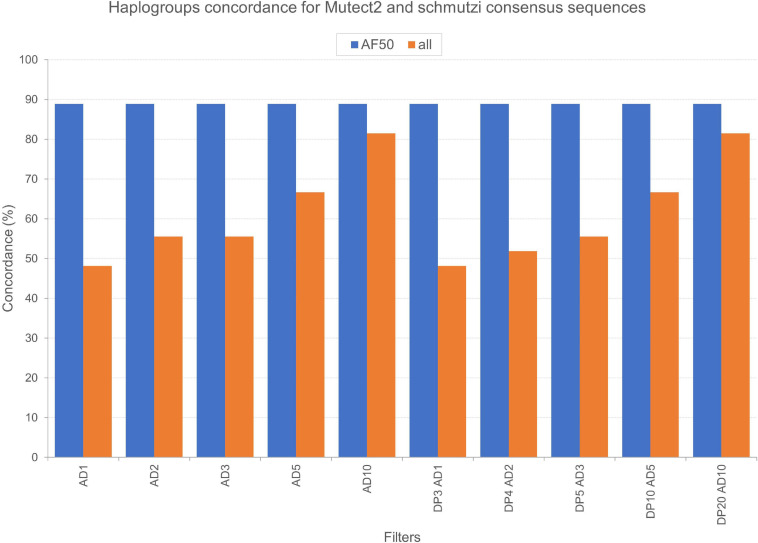
Concordance of haplogroups predicted for Mutect2 and schmutzi consensus sequences of Polizzello samples. The percentage of concordance was calculated on the whole dataset by comparing haplogroups predicted for consensus sequences generated from Mutect2 variants, filtered according to different patterns of filters, to haplogroups assigned to schmutzi consensus sequences. Mutect2 sequences included variant alleles with minimum fraction = 50% (AF50) or alternatively all those detected in non-multiallelic sites (all). AD1, minimum variant allele depth = 1; AD2, minimum variant allele depth = 2; AD3, minimum variant allele depth = 3; AD5, minimum variant allele depth = 5; AD10, minimum variant allele depth = 10; DP3, minimum total depth = 3; DP4, minimum total depth = 4; DP5, minimum total depth = 5; DP10, minimum total depth = 10; DP20, minimum total depth = 20.